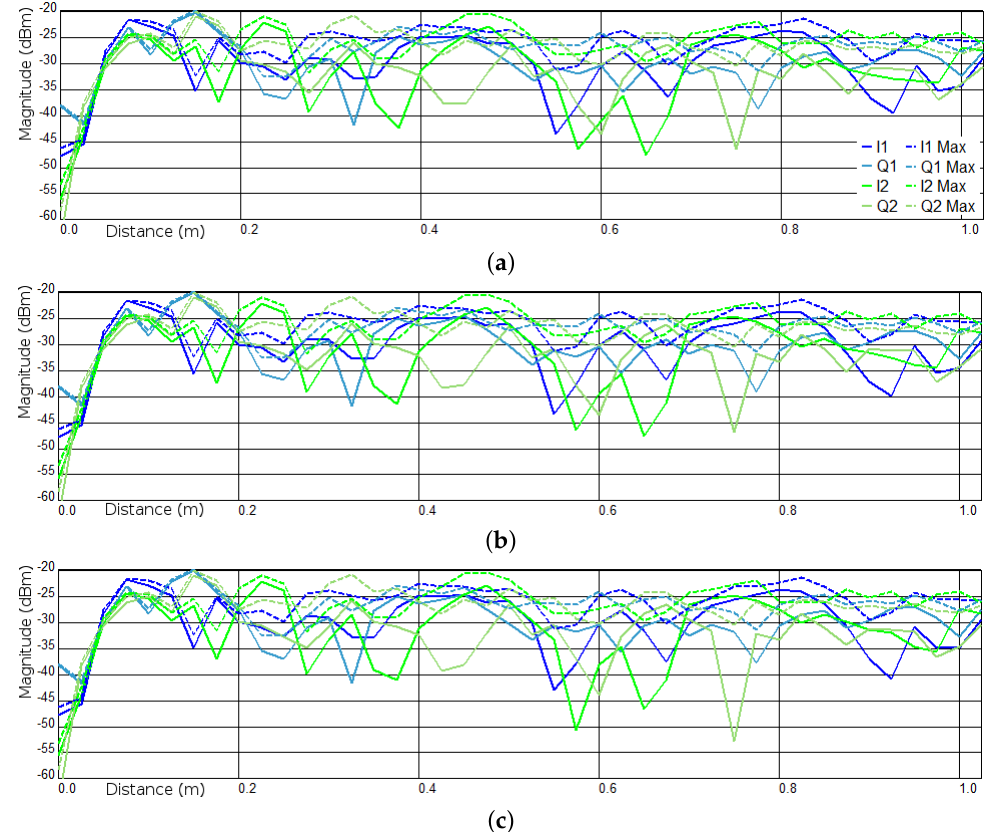
Figure A3. Frequency domain data plots: ( a , b ) for no-insect conditions, ( c ) an insect in H2 (notice the higher amplitudes). Vertical axes are the magnitude levels in dBm; horizontal axes are the distances in